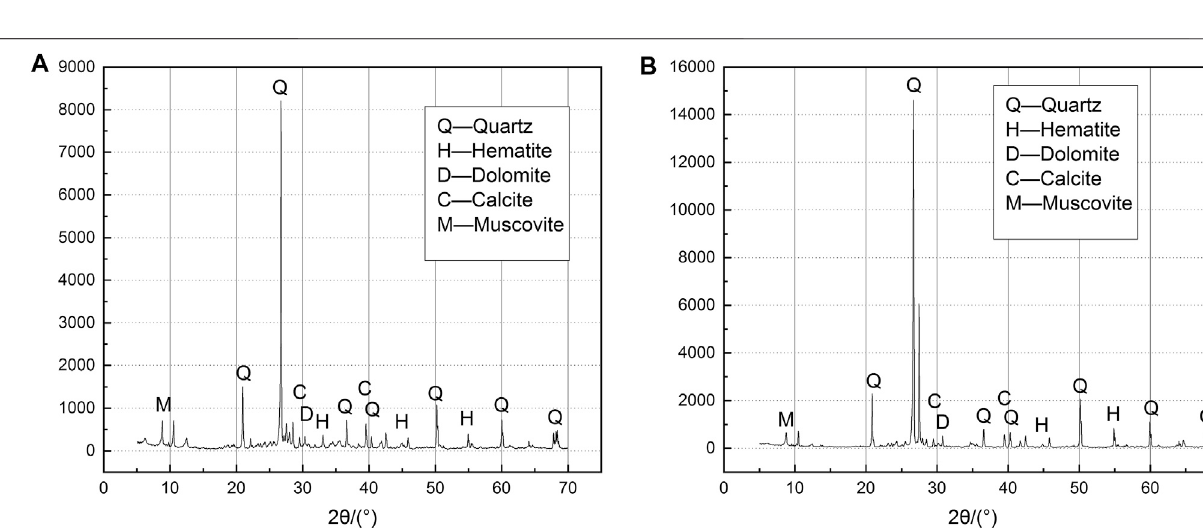
Frontiers in Materials |